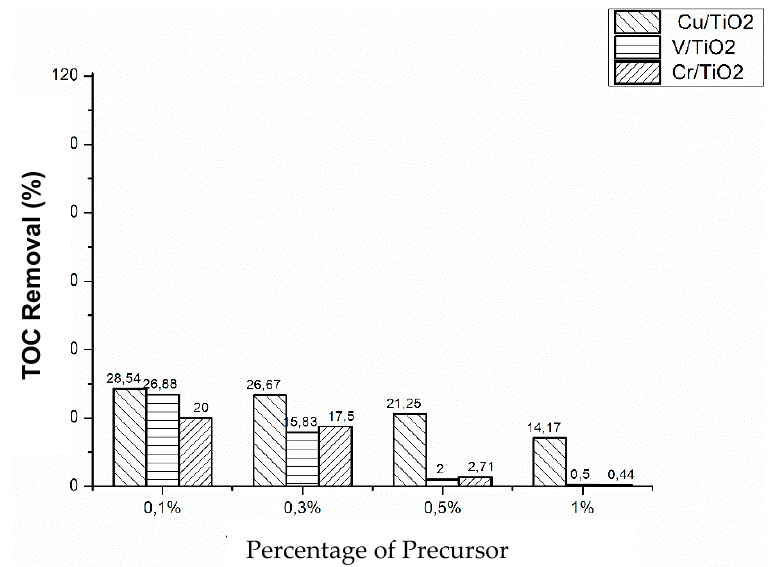
Figure 11. TOC removal during the during photocatalytic degradation of phenol over M(X%) / TiO 2 after 60 min under UV irradiation. [Phenol]0 = 50 mg · L − 1 , [M(X%) / TiO 2 ]0 = 1.0 g · L − 1 , natural pH, and T = 298.0 K.